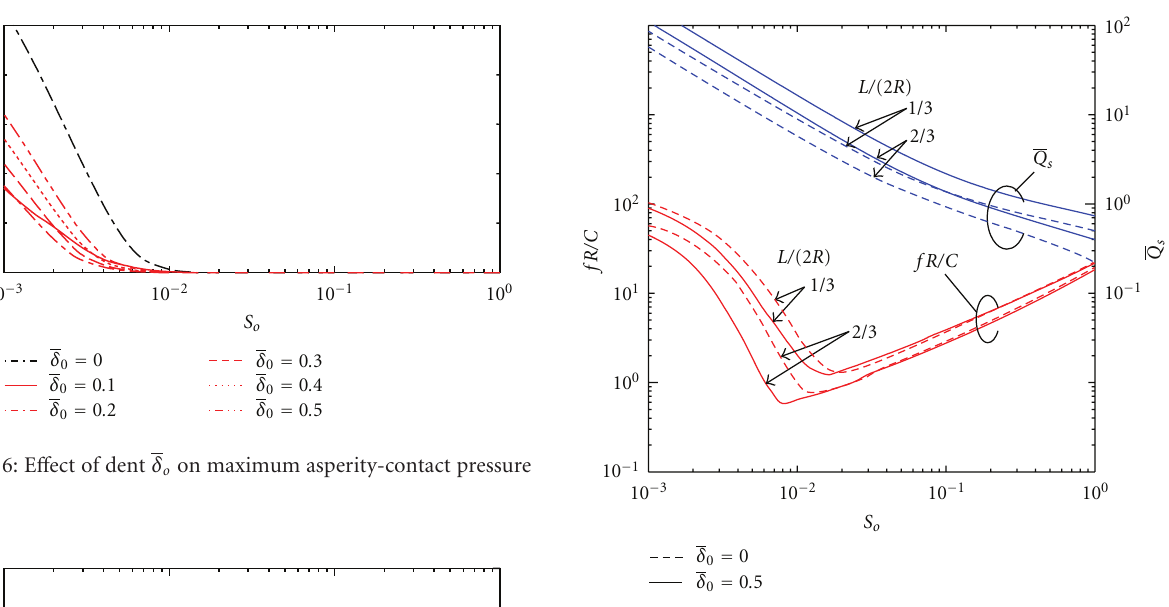
in terms of Sommerfeld s